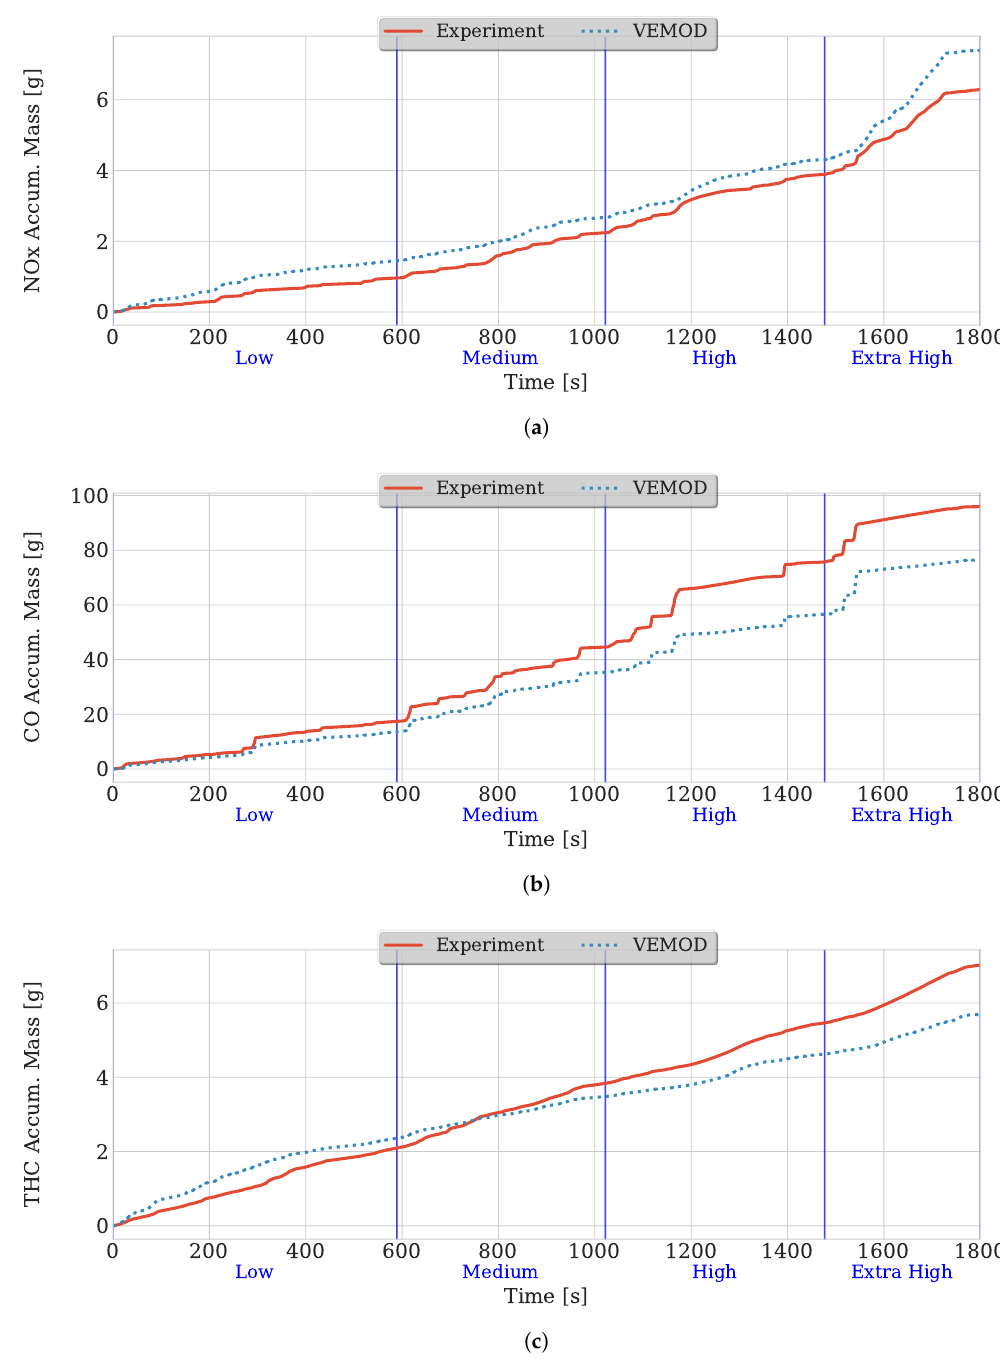
Figure 6. Worldwide Harmonized Light-Duty Vehicles Test Cycle (WLTC) model emissions, engine start at 20 ◦ C room temperature. ( a ) accumulated NO x mass; ( b ) accumulated CO mass; ( c ) accumulated total hydrocarbons